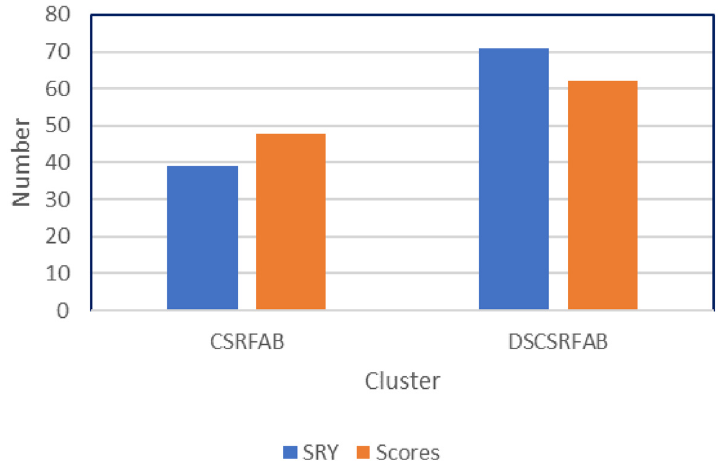
Figure 8. Comparative accuracy of screening continuous growth using yield increase overtime evaluation and using a 1 to 9 scale (discontinuous storage root formation and bulking (DSRFAB) and continuous storage root formation and bulking (CSRFAB) genotypes. Note. SRY: storage root